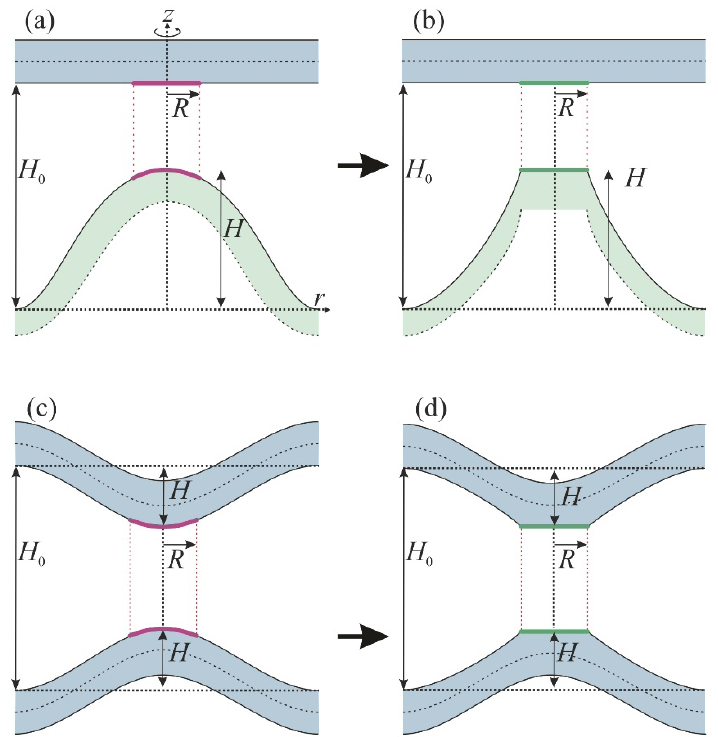
Figure 2. Schematic representation of the membrane remodeling prior to stalk formation in the cases of monolayer–bilayer (panels ( a , b )) and bilayer–bilayer (panels ( c , d )) fusion. The initial distance between the membranes is equal to H 0 , the height of the monolayer dimple is denoted by H and the total height of bilayer dimples in ( c , d ) is 2 H . Radius R of the dimple limited the effective area of hydration repulsion, denoted by crimson on panels ( a , c ), and hydrophobic interaction, denoted by green on panels ( b , d ). The bilayer membrane is colored blue-green and the monolayer membrane is colored ghostly green. Note the axial symmetry of the system.